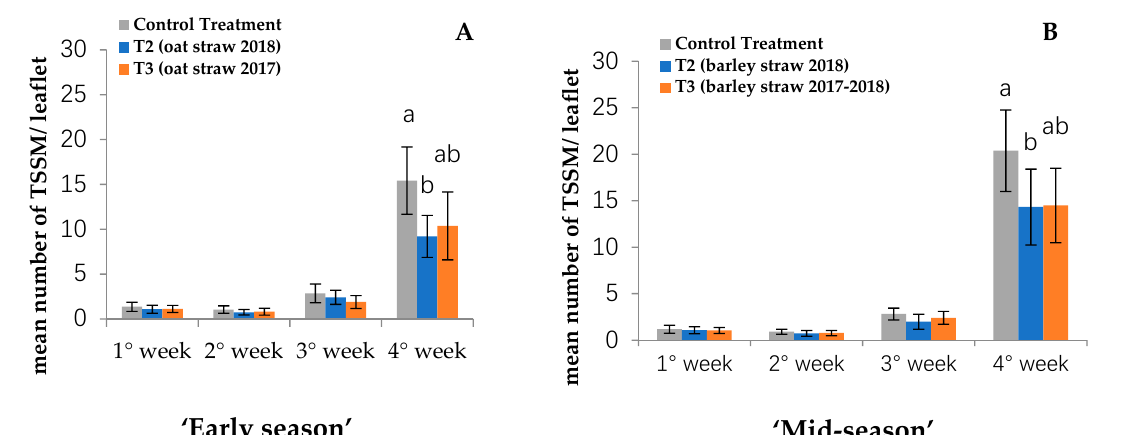
Figure 2. Weekly mean number of Tetranychus urticae observed on six marked leaflets per plant ( n = 13 plants per treatment). ( A ): ‘Early season’ experiment (T2, oat straw since 2018; T3, oat straw since 2017); ( B ): ‘Mid-season’ experiment (T2, barley straw since 2018; T3, barley straw lower half layer since 2017 and top half layer since 2018. Light was on from 6 AM to 9 PM.